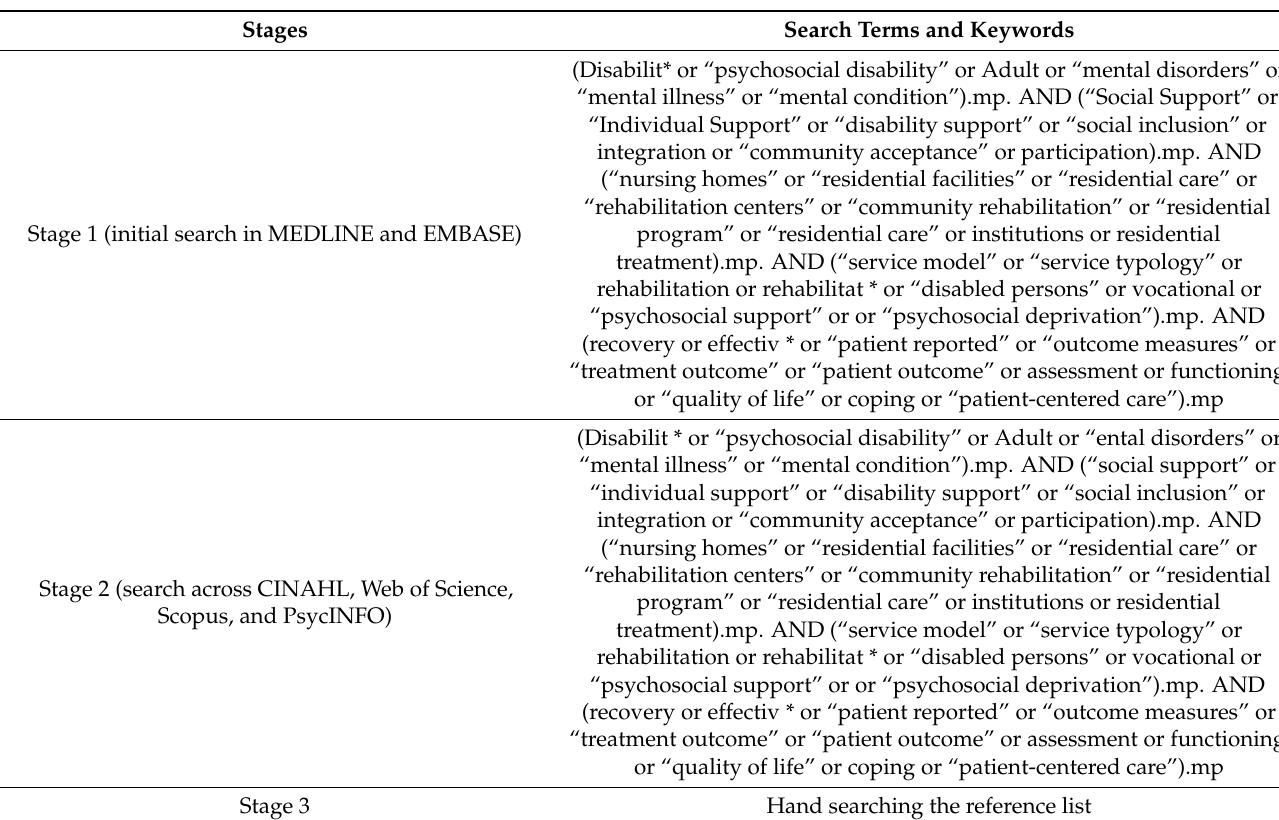
Table 1. Search strategy and selection